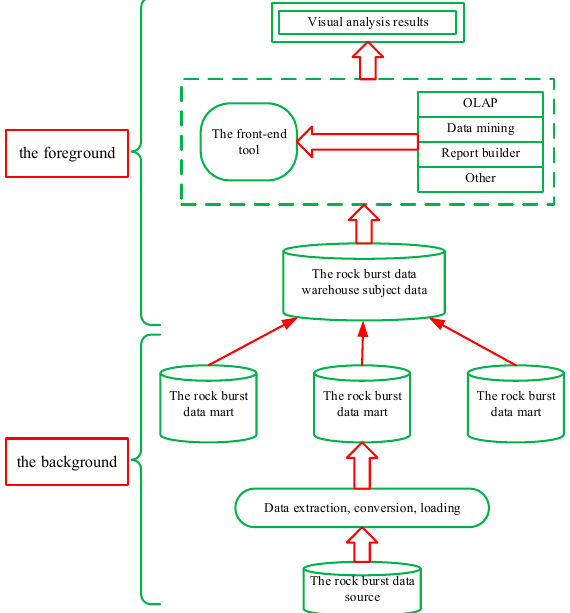
Figure 2. Architecture of rock burst data warehouse.